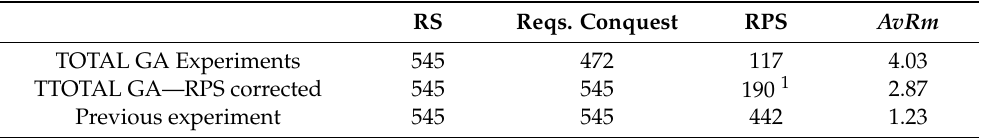
Table 8. Correction of RPS found in our experiments. This allows a comparison of our experiment with the previous